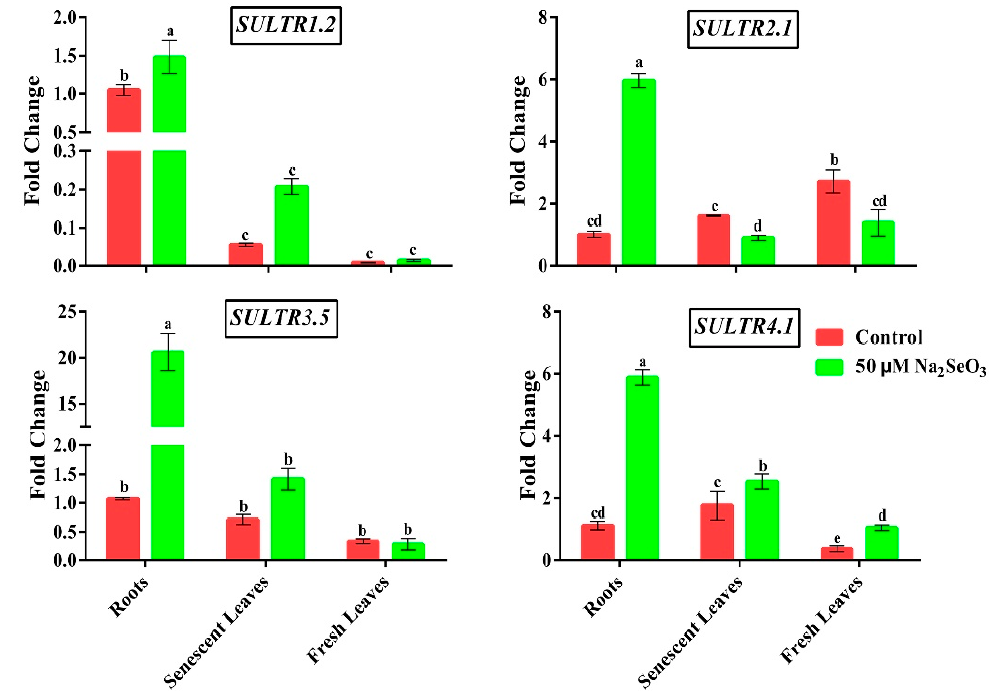
Figure 4. Effect of Se on the transcript levels of genes involved in sulfate uptake and transport. The data were analyzed using the 2 −ΔΔ Ct method, and the gene expression abundance in broccoli roots from the control group was defined as 1 (the same below). Different letters indicate significant differences compared to roots under control.